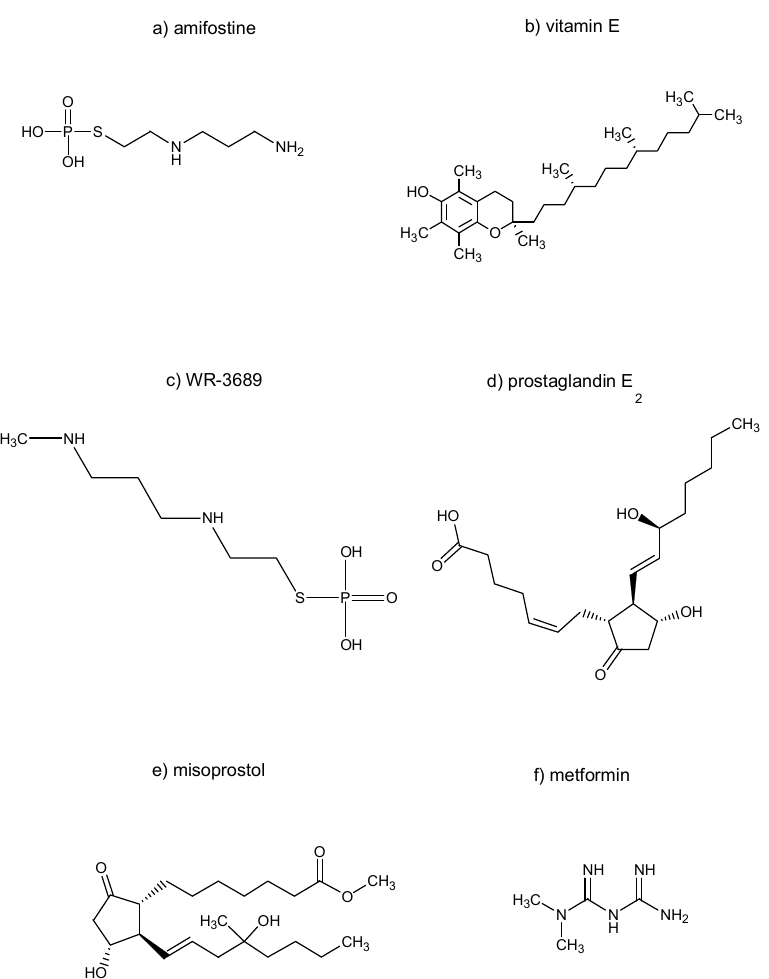
Figure 1. Chemical structures of selected substances explored in Section 2.